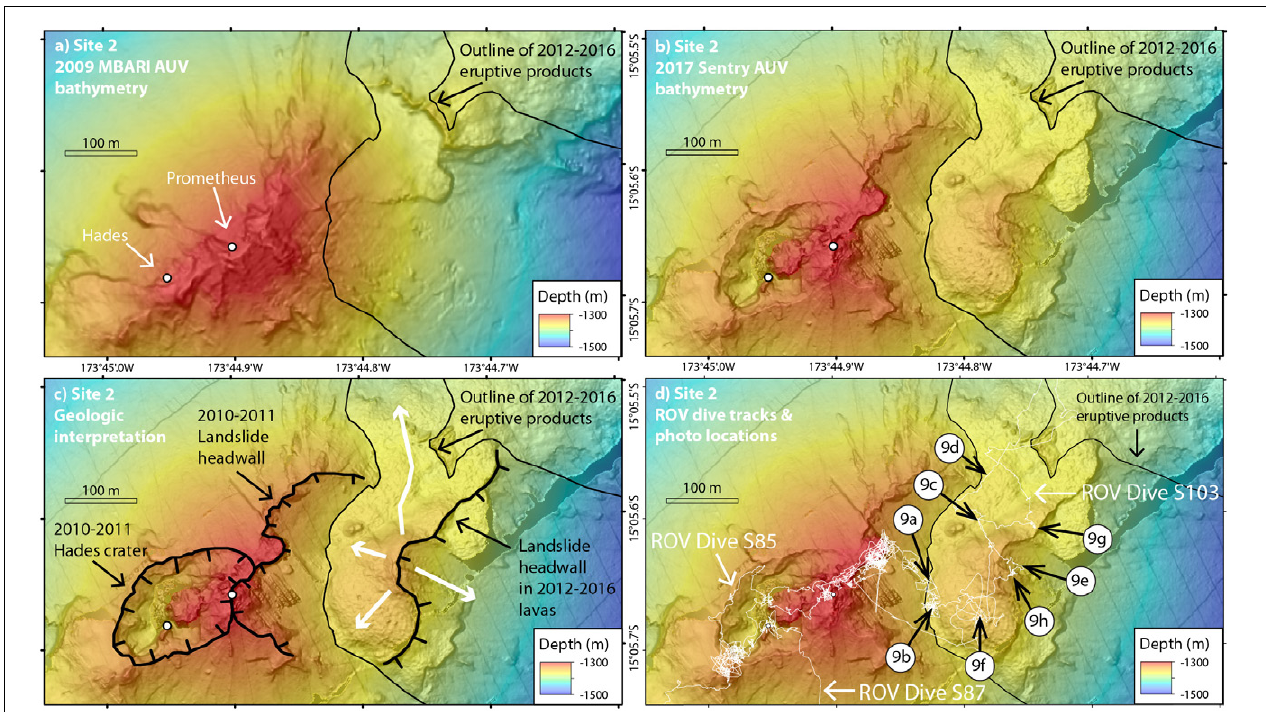
FIGURE 8 | Close-up maps of eruption site #2 showing (a) pre-eruption MBARI AUV bathymetry from 2009, (b) post-eruption Sentry AUV bathymetry from 2017, (c) geological interpretation on 2017 AUV bathymetry and (d) tracklines of SuBastian ROV dives S85, S87, and S103 (white lines) on post-eruption Sentry AUV bathymetry, with locations of images in Figure 9 (white numbered circles). Thick white arrows in (c) indicate lava flow directions from eruptive vent; thick black hachured lines are crater rims or landslide headwalls. Thin black outlines enclose the site #2 eruption deposits. White dots show locations of Hades and Prometheus eruptive vents in May